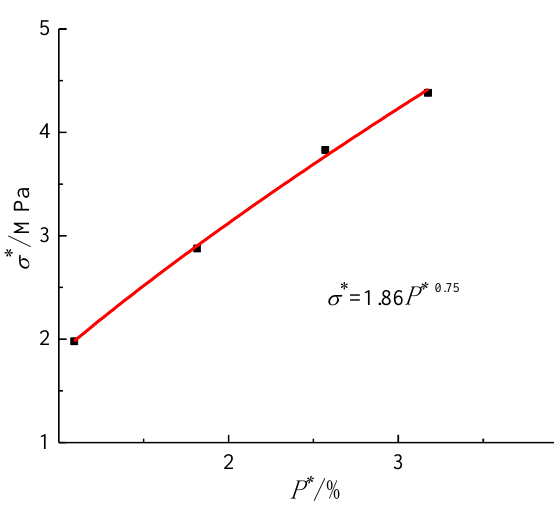
Figure 10. Curve of B and N fitting values.